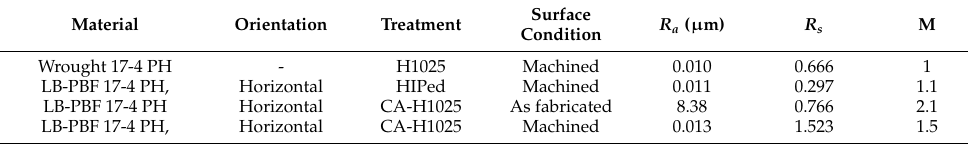
Table 6. Surface finish and microstructural factors for 17-4 PH ( σ 0 = 729